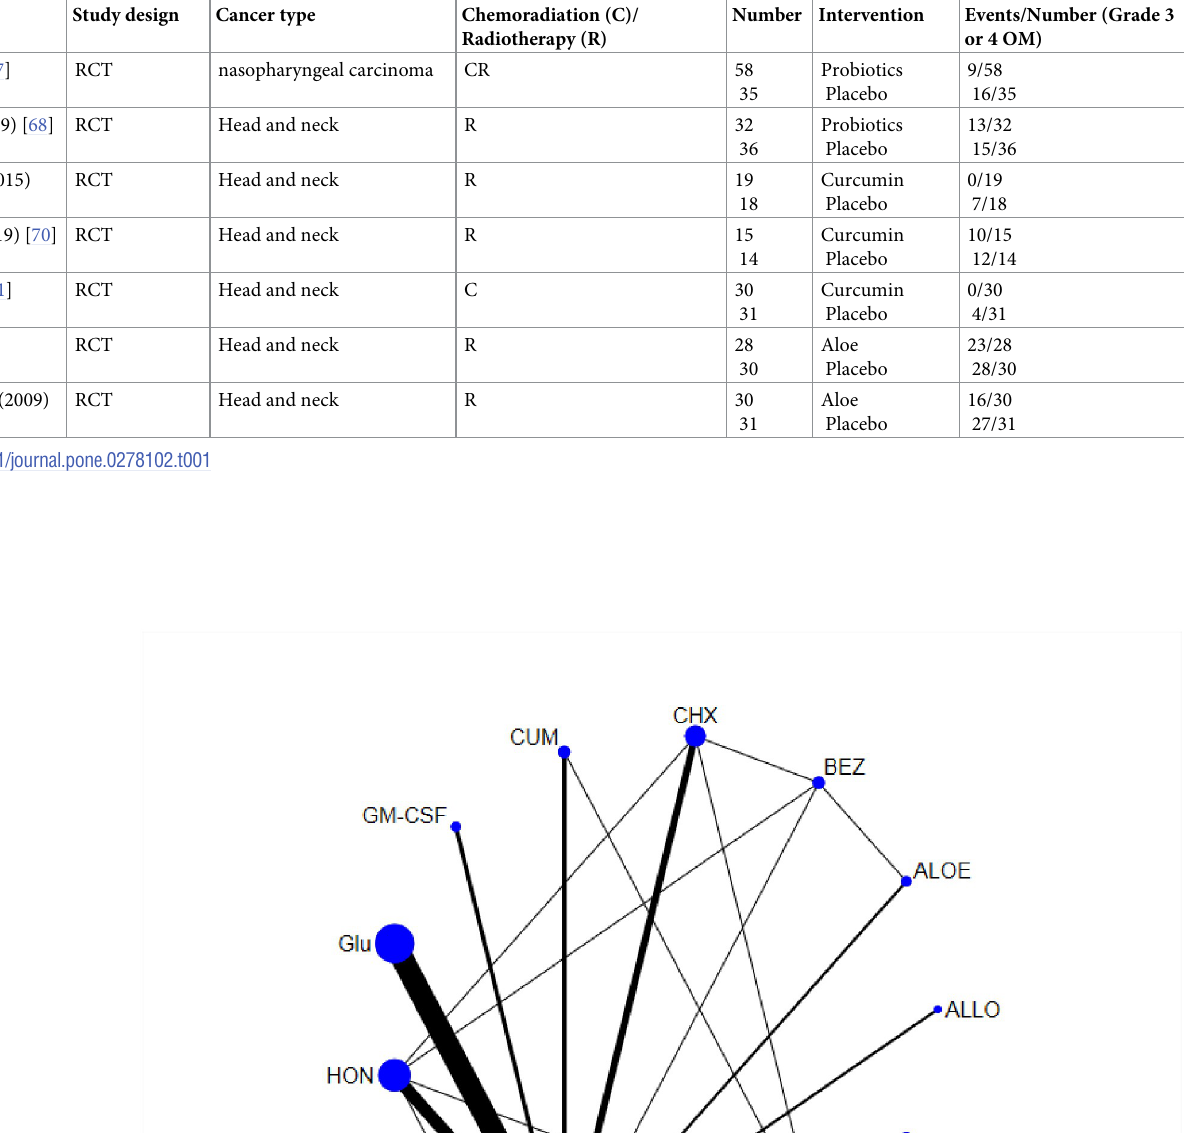
PLOS ONE | https://doi.org/10.1371/journal.pone.0278102 December8,